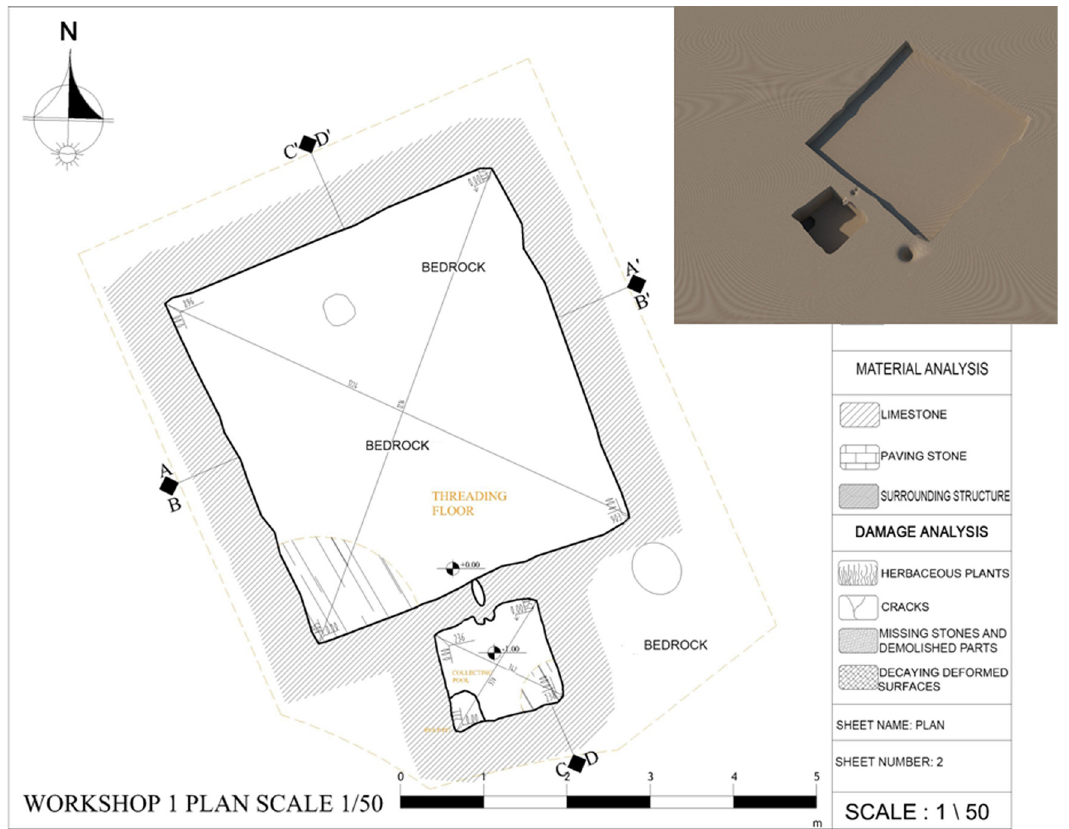
Figure 3: 1/50 plan of WS1 - oriented N – S and 3D drawing ( Ambarçay Salvage Excavation Archive )